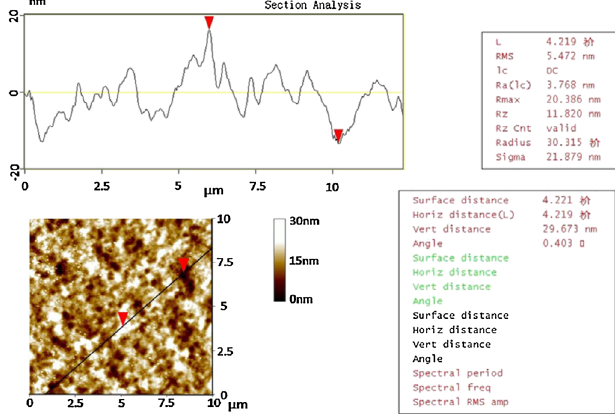
FIG. 10. (Color) The AFM images of the niobium sample sur- face treated by BEP.